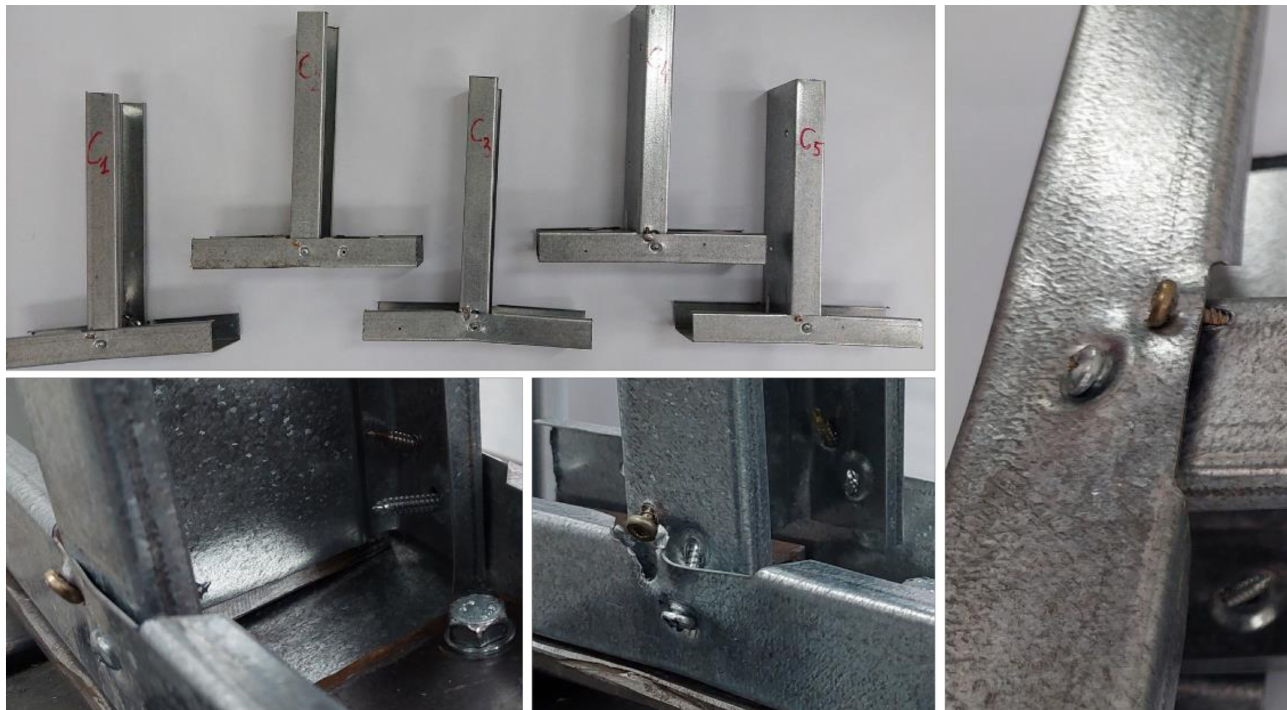
Figure 18. Joint C tested